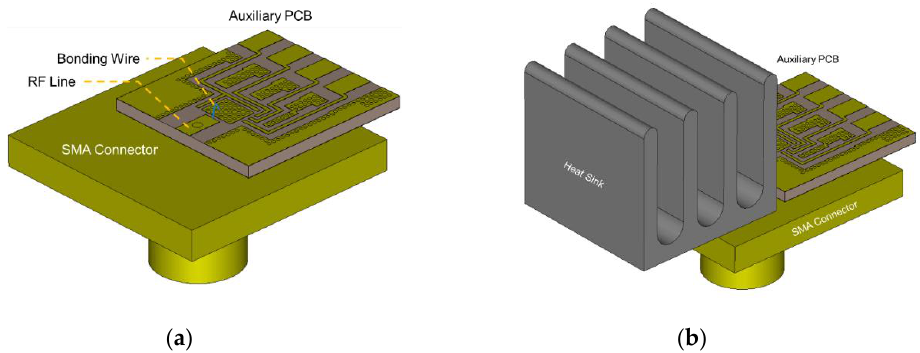
Figure 9. Transition structure of the auxiliary PCB and SMA connector ( a ) without and ( b ) with a heat sink.